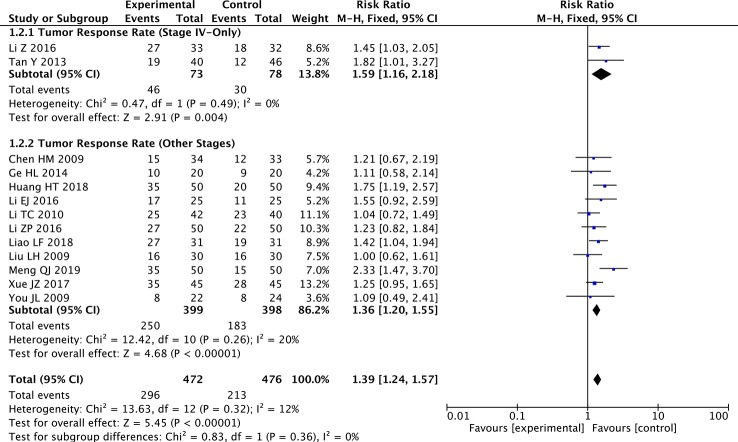
Forest plot of subgroup meta-analysis of TRR according to TNM stages.